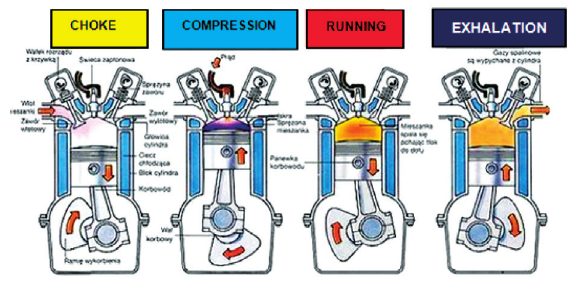
Fig. 2. Four-stroke engine work